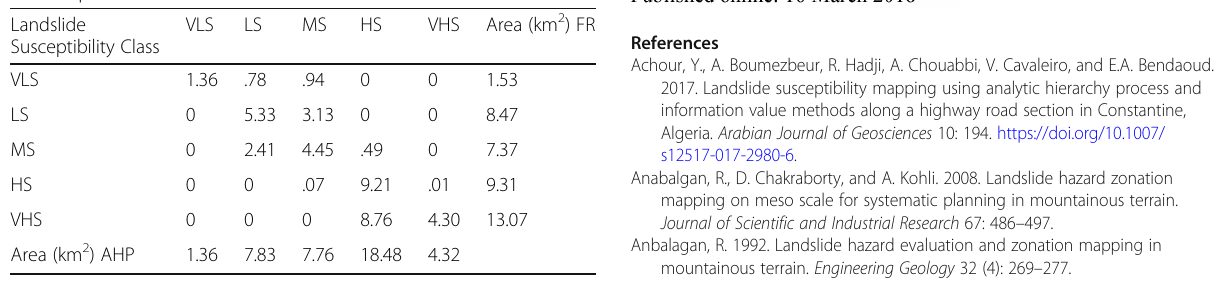
Table 7 Shows the error matrix for computing spatially agreed area between the landslide susceptibility classes in AHP and